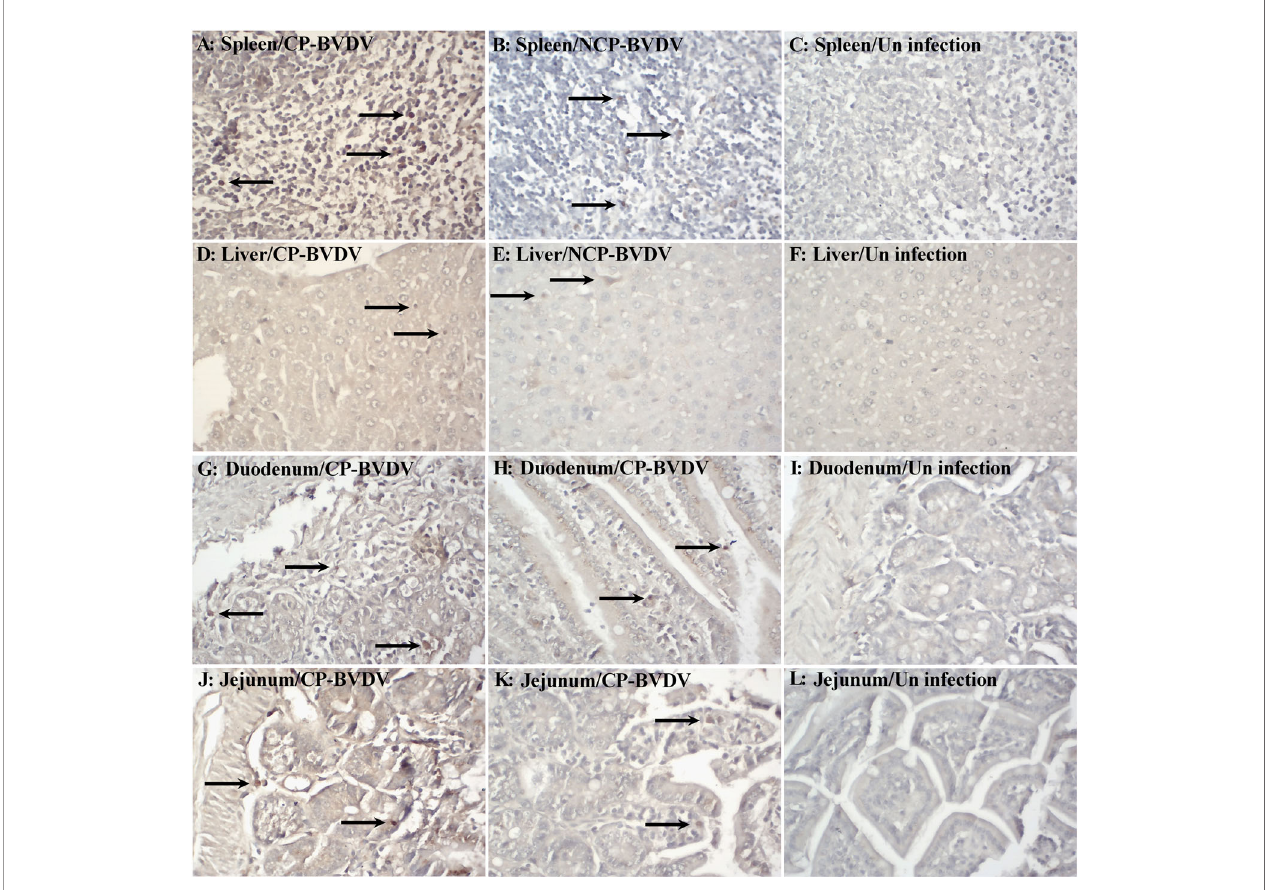
FIGURE 1 | Immunohistochemistry for BVDV antigen at day 7 of post-infection. Viral antigen was detected in the spleen [ (A) CP BVDV; (B) NCP BVDV], liver [ (D) CP BVDV; (E) NCP BVDV], duodenum [ (G) CP BVDV; (H) NCP BVDV], and jejunum [ (J) CP BVDV; (K) NCP BVDV]. Images of the spleen (C) , liver (F) , duodenum (I) , and jejunum (L) of negative control mice are also shown (original magni fi cation,